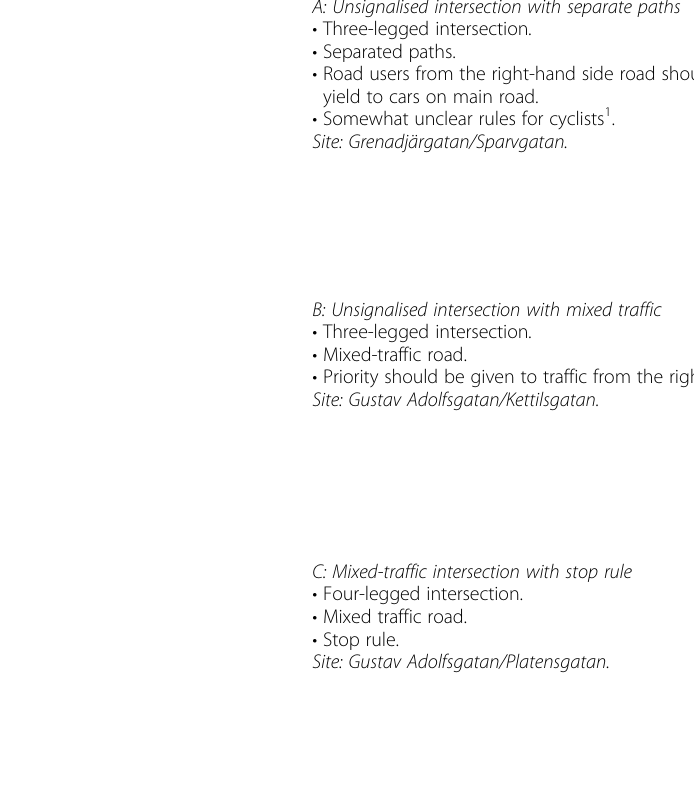
A: Unsignalised intersection with separate paths (cid:129) Three-legged intersection. (cid:129) Separated paths. (cid:129) Road users from the right-hand side road should yield to cars on main road. (cid:129) Somewhat unclear rules for cyclists 1 . Site: